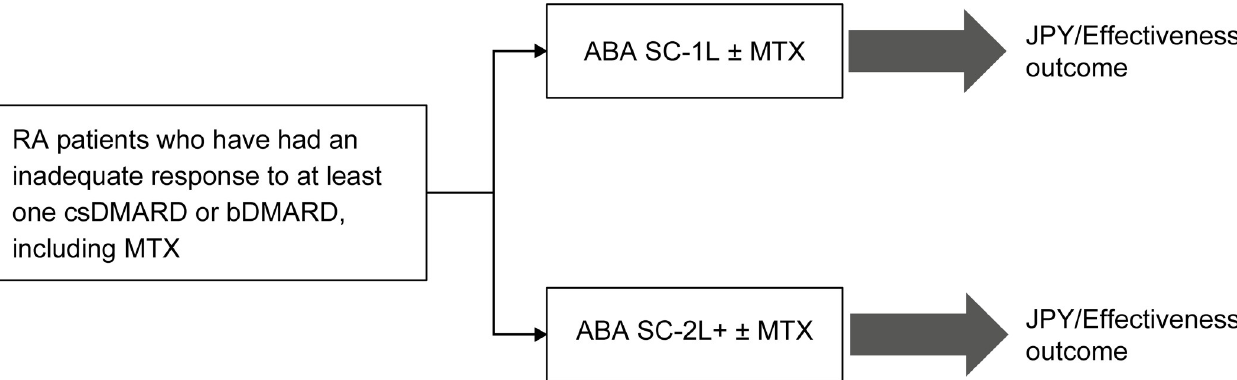
Fig 2. Decision tree structure (ABA-1L vs. ABA-2L+). The target population was RA patients who had an inadequate response to prior treatment with at least one csDMARD or bDMARD, including MTX, in clinical practice. The cost-effectiveness was compared between ABA SC 1L ± MTX and ABA SC 2L+ ± MTX. 1L, first line; 2L+, second or later line; ABA, abatacept; bDMARD, biological DMARD; csDMARD, conventional synthetic disease-modifying antirheumatic drug; JPY, Japanese Yen; MTX, methotrexate; RA, rheumatoid arthritis; SC, subcutaneous; TNFi, tumour necrosis factor inhibitor.